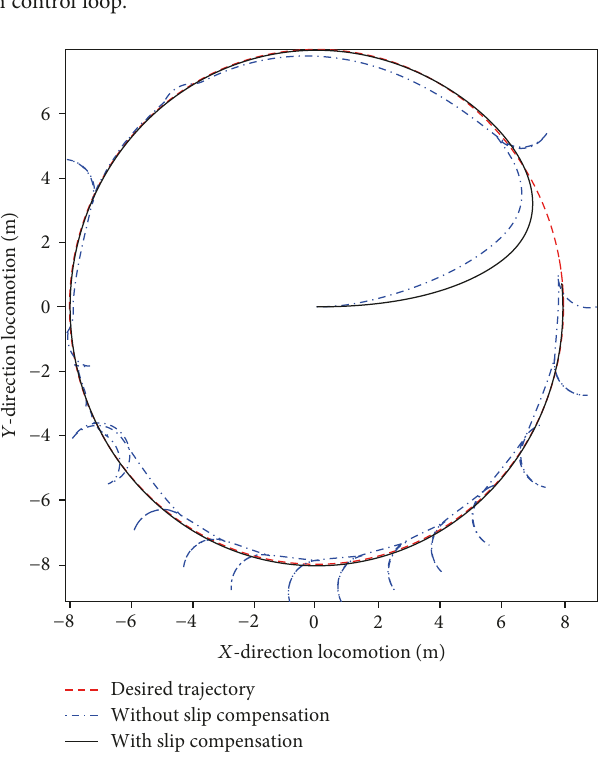
Figure 4: The position comparison with active slip